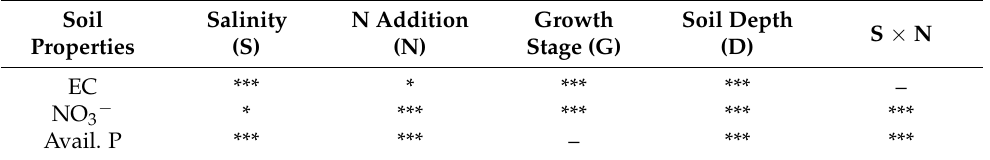
Table 3. Results of multiple-way ANOVA on the effects of salinity (S), N addition (N), growth stage (G), soil depth (D) and their interactions on soil salt and nutrient